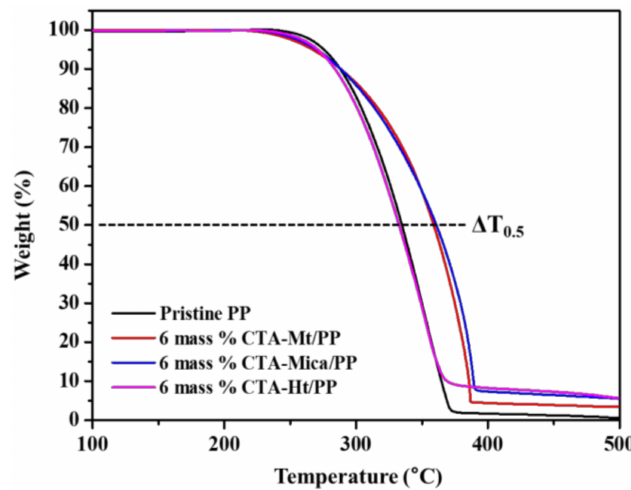
Figure 5. TGA curves for the 6 mass % CTA-clay nanocomposites. The TGA parameters of T 0.5 and ∆ T 0.5 (T 0.5 (nanocomposite)-T 0.5 (pristine PP))